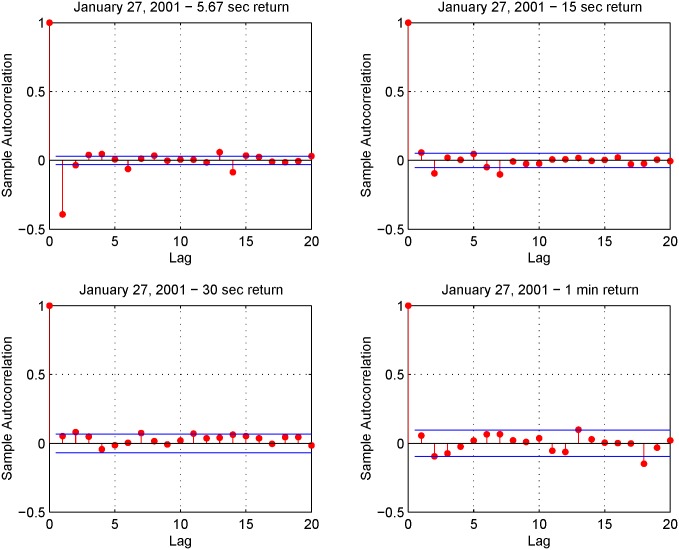
Autocorrelation for various sampling intervals on January 27, 2001.Upper left panel (5.67-second returns), upper right panel (15-second returns), lower left panel (30-second returns) and lower right panel (1-minute returns).